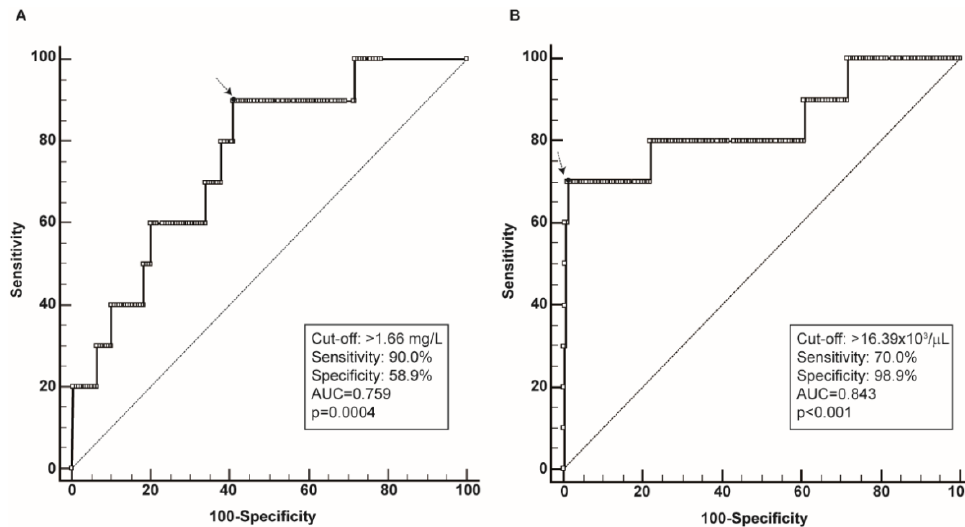
Figure 1. ROC curves of calprotectin levels and neutrophil count in relation to survival. The ROC curve is indicated by a bold line and full circles represent the different criterion points. The open circle indicates the best cut-off point. The dotted line indicates the bisector. AUC = area under the curve. ( A ). ROC curve of calprotectin levels. ( B ). ROC curve of neutrophil count.